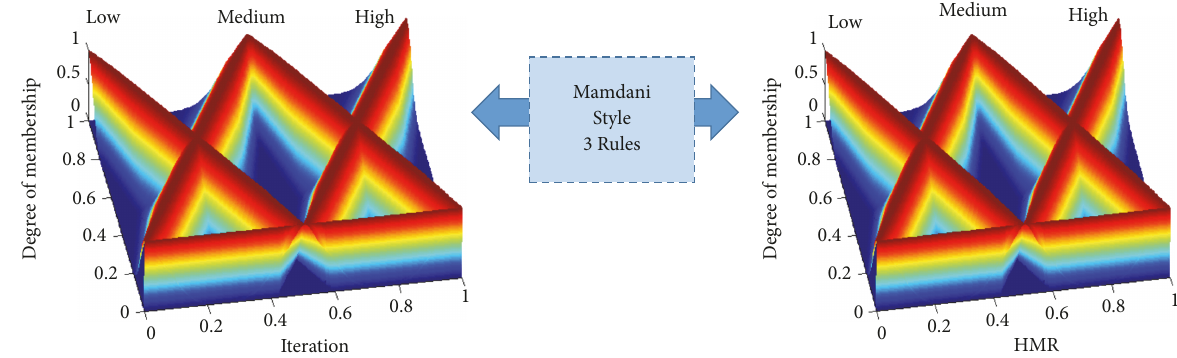
Figure 5: Plot of the generalized type 2 proposed method